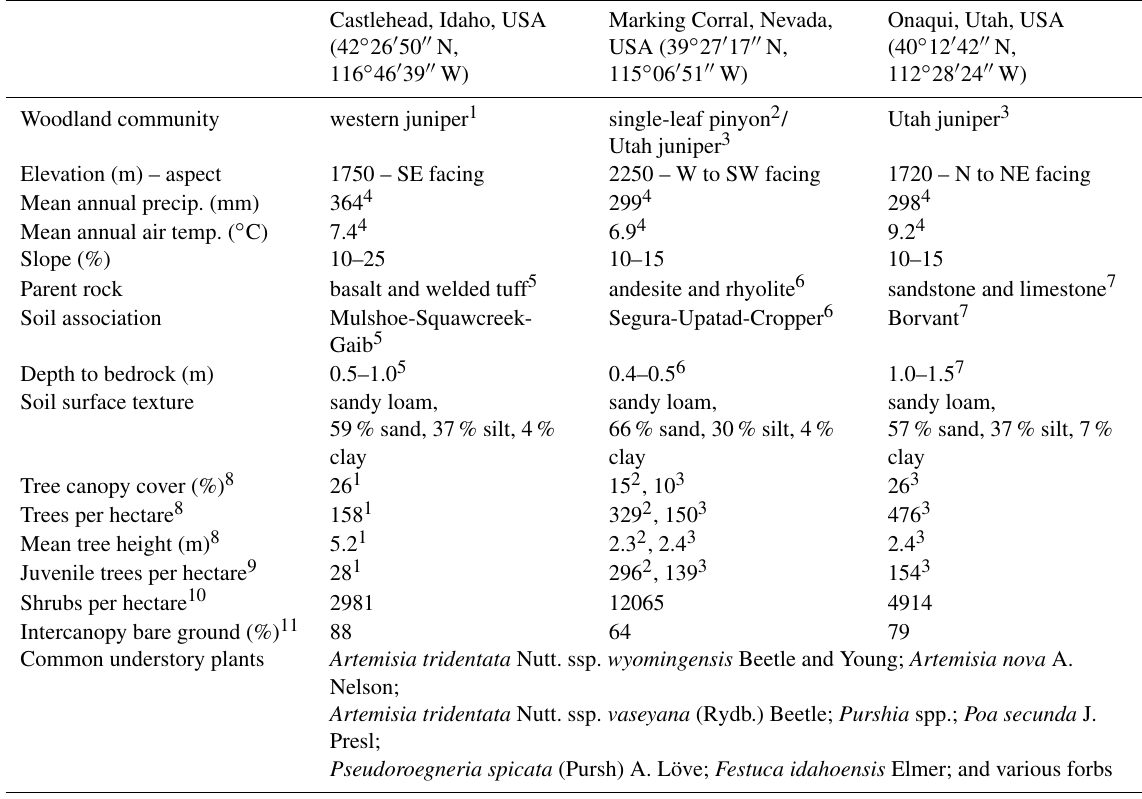
Table 1. Topography, climate, soil, tree cover, and understory vegetation at the Castlehead, Marking Corral, and Onaqui sites prior to treatments. Data are from Pierson et al. (2010, 2015) or Williams et al. (2014a) except where indicated by